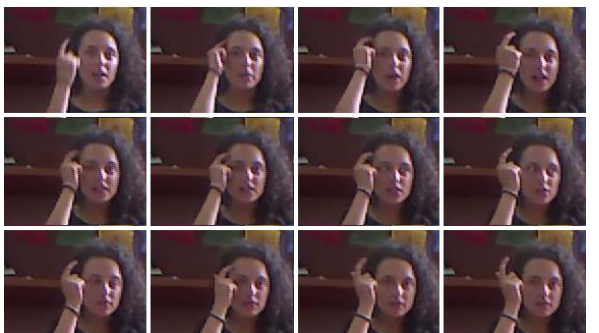
Figure 2. Sample00827, frames 1175-1231